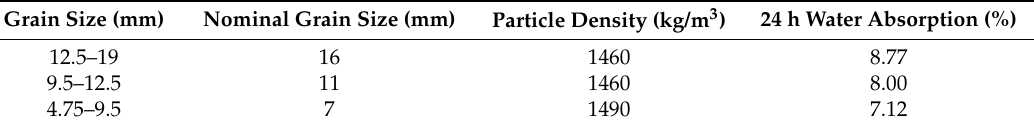
Table 1. Basic properties of lightweight aggregates.